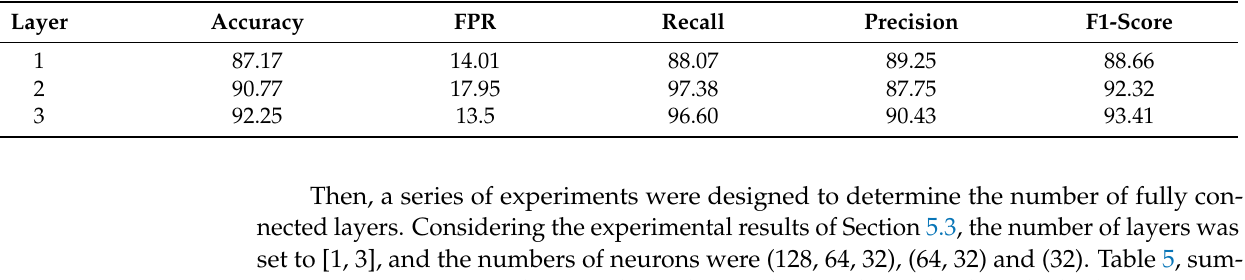
Table 4. Performance analysis on NSL-KDD for different numbers of convolutional layers.